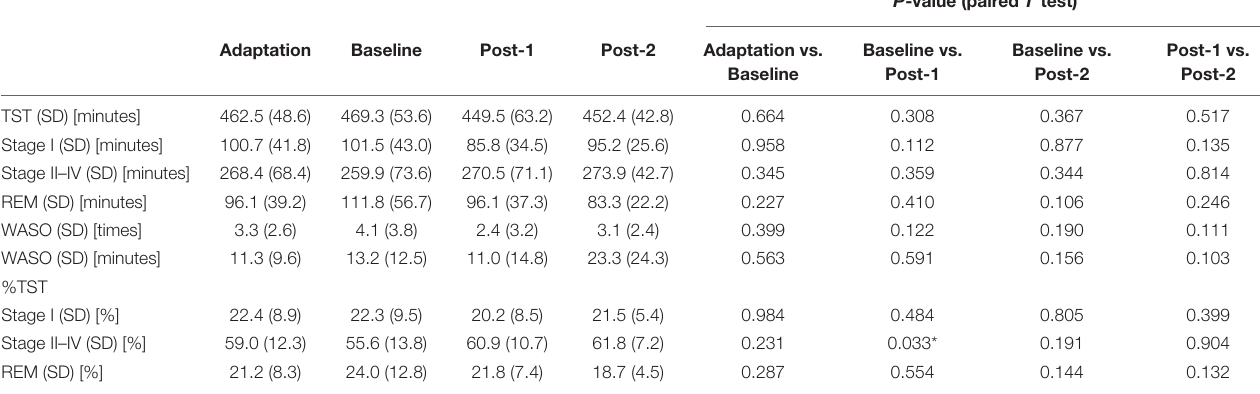
TABLE 1 | Sleep variables.